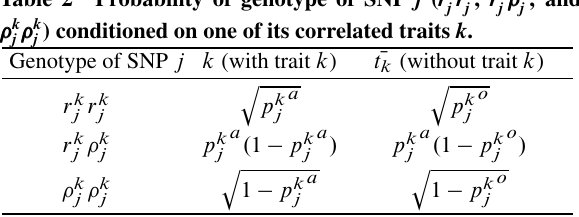
Table 2 Probability of genotype of SNP j ( r k (cid:26)(cid:26)(cid:26) k (cid:26)(cid:26)(cid:26) k ) conditioned on one of its correlated traits k j j